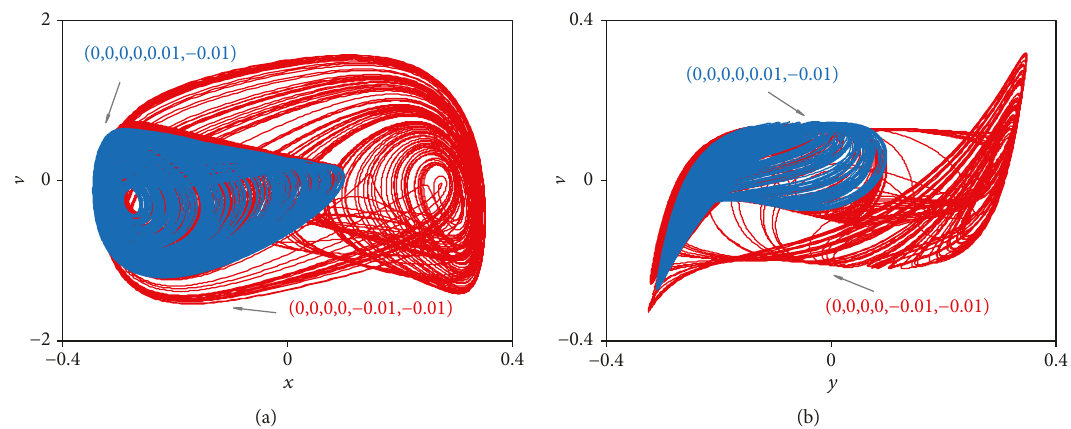
Figure 8: Coexisting chaotic attractors with di ff erent initial state. (a) Coexisting chaotic attractors on the x - v plane. (b) Coexisting chaotic attractors on the y - v